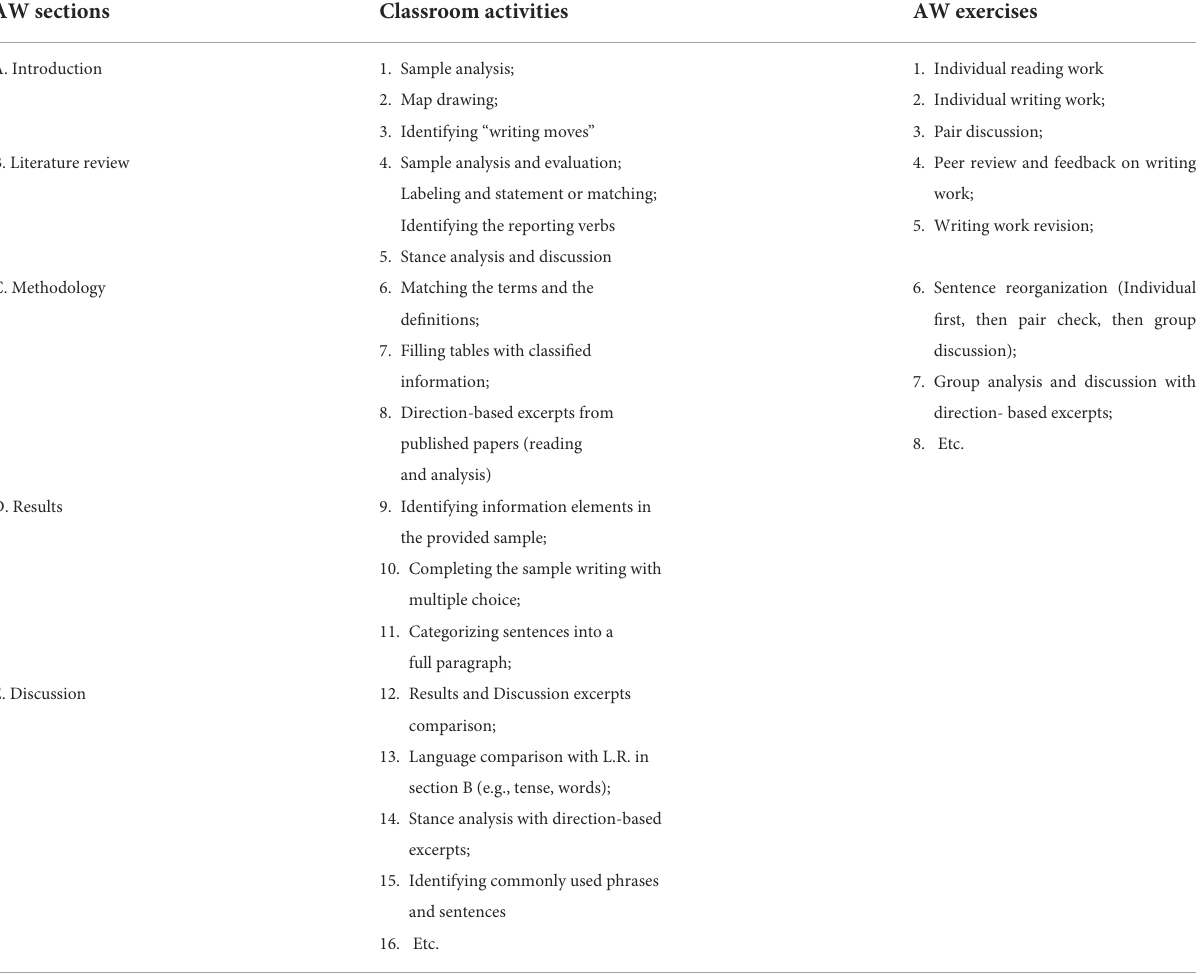
TABLE 2 Classroom activities and exercises in Christine’s academic writing